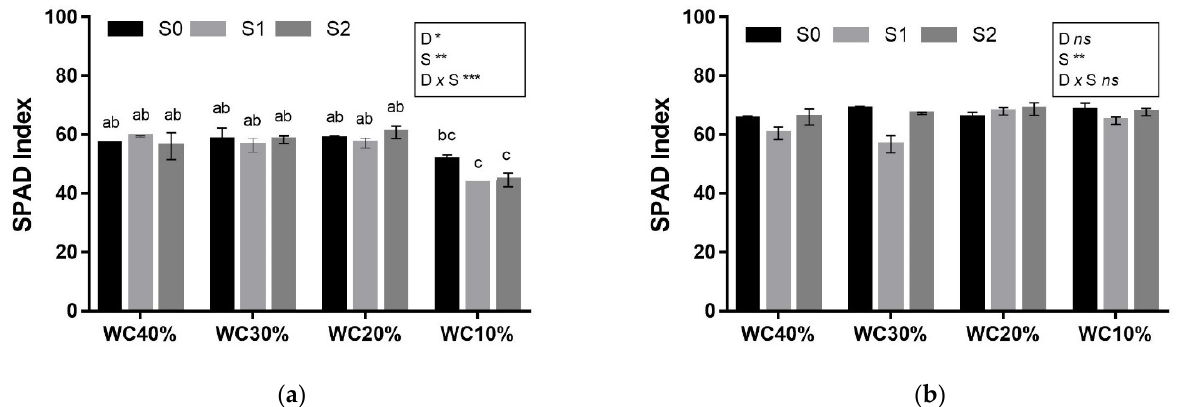
Figure 3. SPAD index in Callistemon ( a ) and Viburnum ( b ) potted plants subjected to drought (WC40%: control; WC30%: